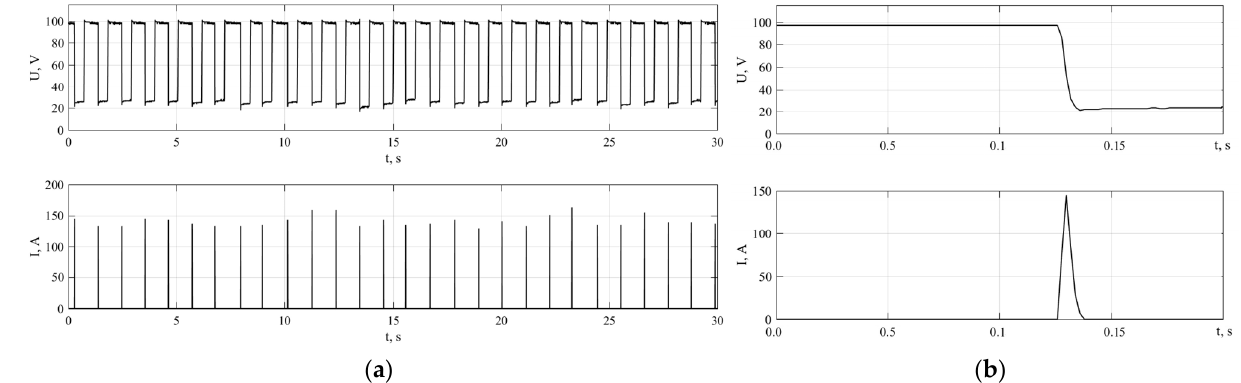
Figure 5. Typical oscillogram of the pulse generation process ( a ); single pulse ( b ).